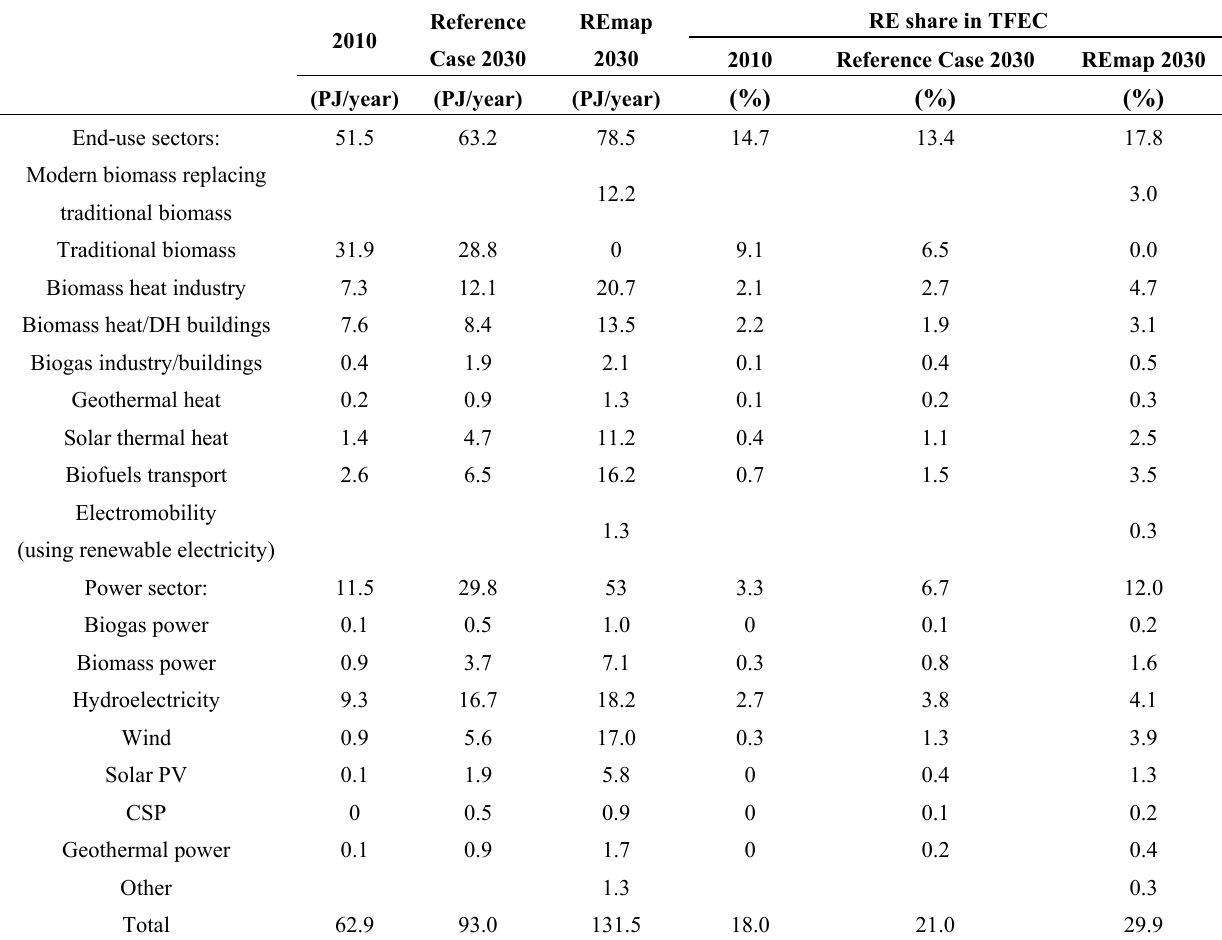
the Reference Case and REmap Options in